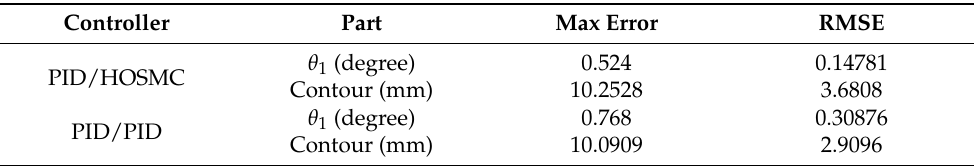
Table 10. Comparison table of the tracking results on the circular trajectory at zero load based on theta axis control.